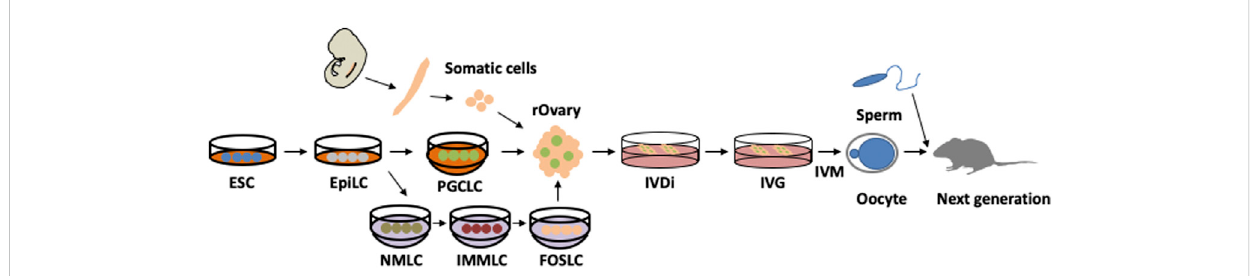
FIGURE 4 Invitro culturefor entireoogenesisfrompluripotentstemcells. Embryonic stemcells(ESCs)areinducedtoprimordialgermcell-likecells(PGCLCs) via epiblast-like cells (EpiLCs) by mimicking in vivo development. PGCLCs are further differentiated in a recombinant ovary (rOvary) by aggregation with embryonic ovarian somatic cells. In vitro differentiation (IVD) generates secondary follicles, which further mature through in vitro growth (IVG). Then, cumulus oocyte complexes are picked up and cultured using in vitro maturation (IVM). After in vitro fertilization (IVF) and transfer to a surrogate mother, healthy offspring are generated. Recently, ovarian somatic cells were also induced from ESCs through EpiLC. First, nascent mesoderm-like cells (NMLCs) were induced from EpiLCs. NMLCs were differentiated to intermediate mesoderm-like cells (IMMLC) and fi nally induced into fetal ovarian somatic cell-like cells (FOSLCs). These processes are well traced within in vivo